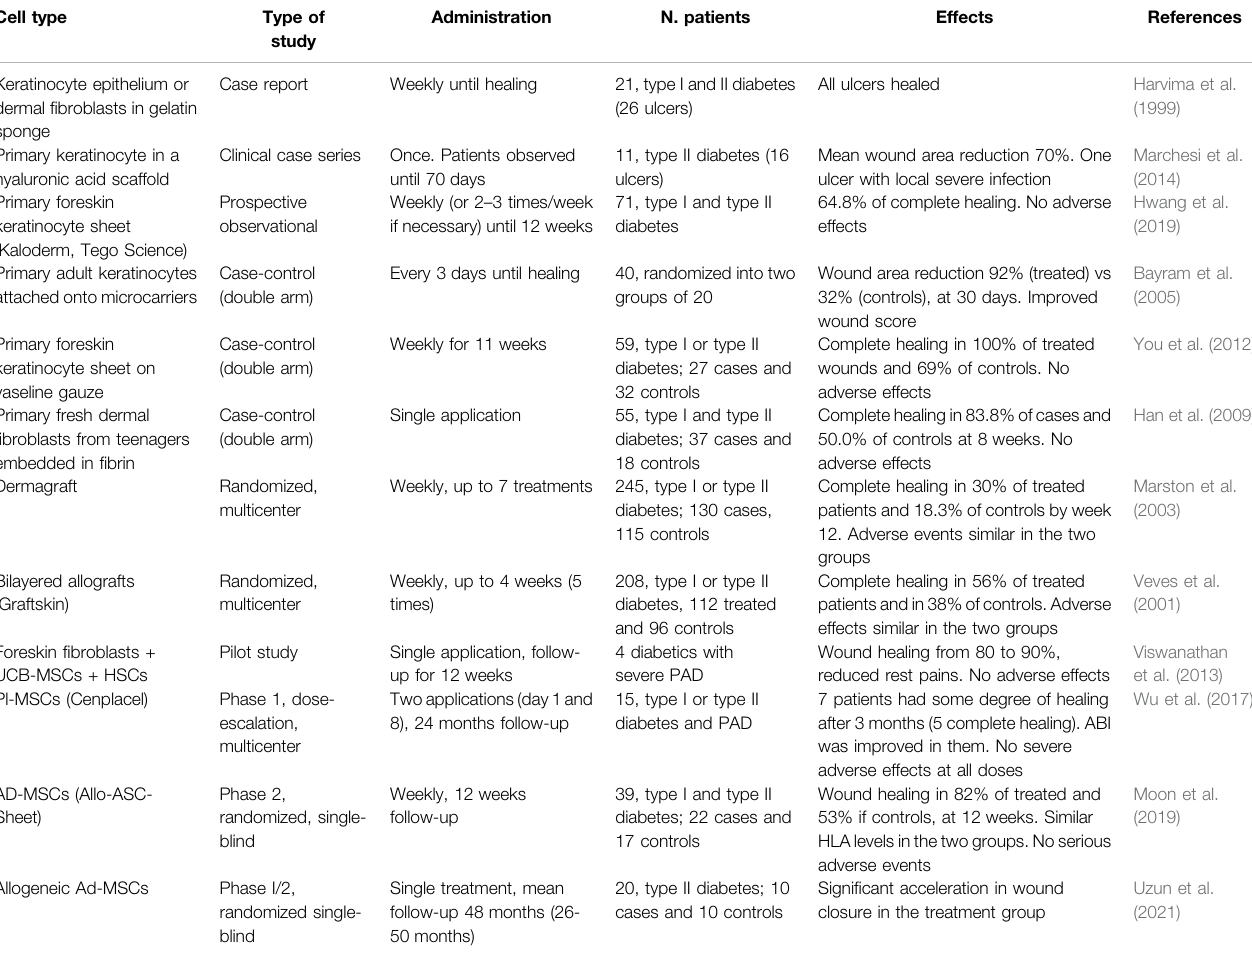
TABLE 1 | Clinical studies on administration of allogeneic cell tools to diabetic ulcers: MSCs, mesenchymal stem cells; Ad-MSCs, adipose tissue-derived MSCs; Pl-MSCs, placenta-derived MSCs; UCB-MSCs, umbilical cord blood-derived MSCs; HSCs, hematopoietic stem cells; ASC, adipose stem cells. Cell